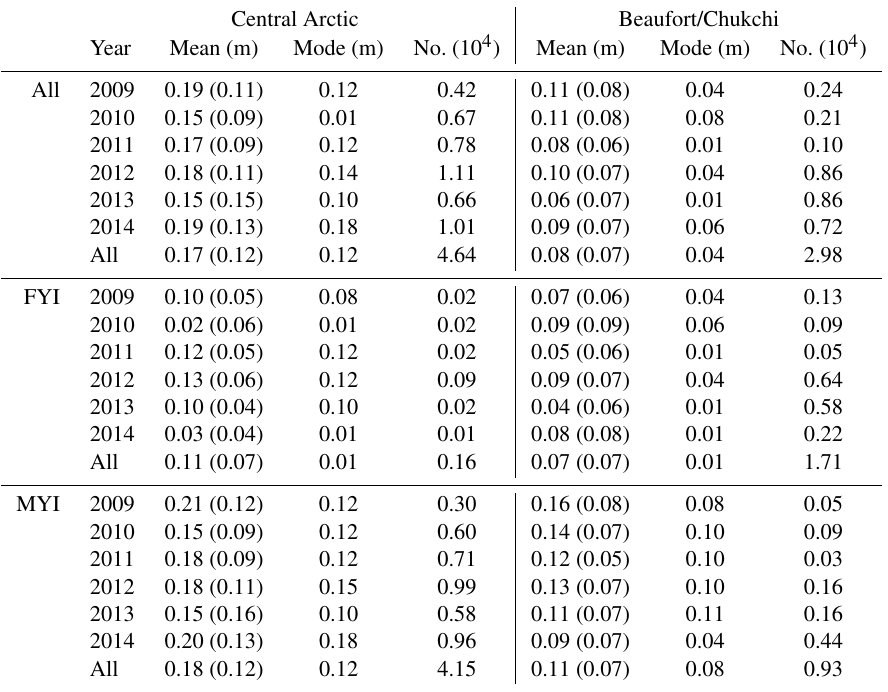
Table 4. Surface feature volume statistics taken from the probability distributions shown in Fig. 9. The value in the brackets (next to the means) equals 1 standard deviation of the relevant distribution. The third column (under each region) shows the number of 1km ATM sections used in each distribution.